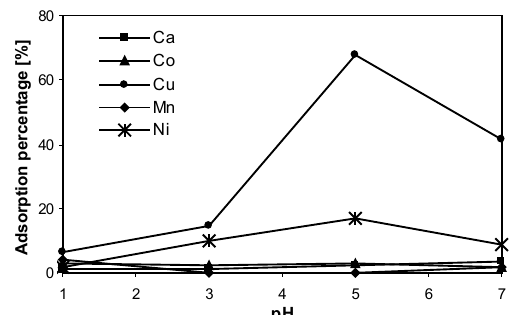
Figure 4. Effect of pH solution on the adsorption percentage of Ca, Co, Cu, Mn, Ni ions by the support 3